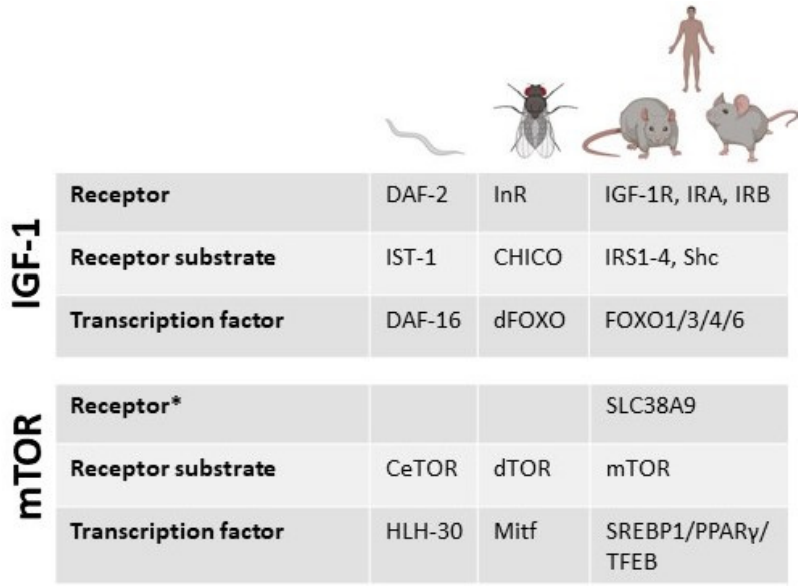
Figure 3. Schematic showing different components of the IGF-1 and mTOR signaling in model organisms. * While cell membrane receptors for IGF-1 are presented for mTOR we include a lysosomal receptor reported in the literature and mentioned within the text.